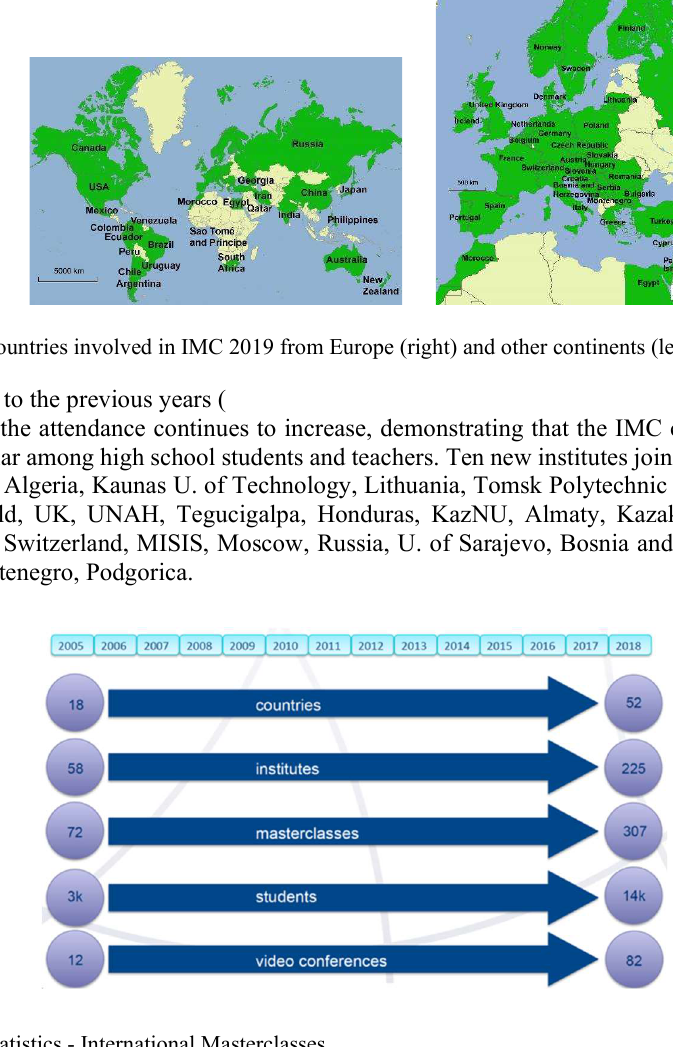
Figure 2. Statistics - International Masterclasses